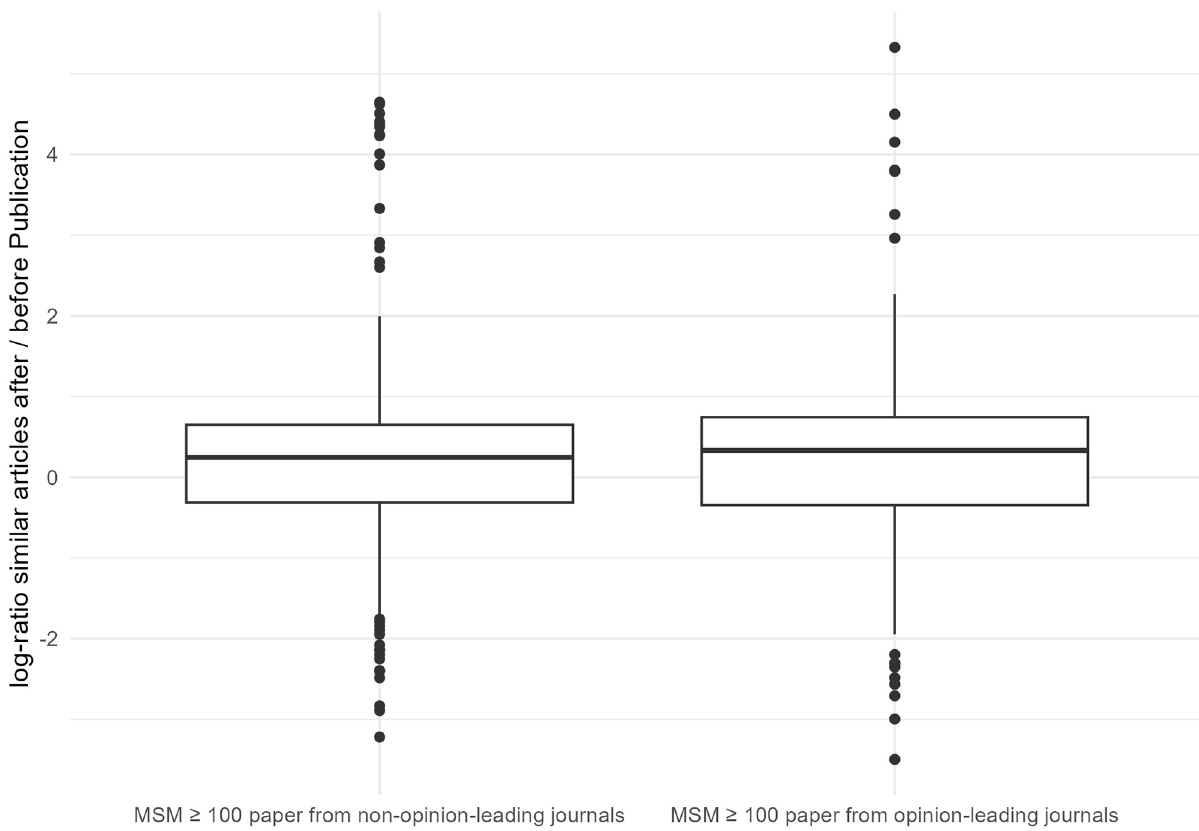
Fig 2. Comparison of increase of similar articles after publication of each MSM � 100 paper originating from non-opinion-leading or opinion- leading journals. Based on: 603 MSM � 100 papers from non-opinion-leading journals and 380 from opinion-leading journals.